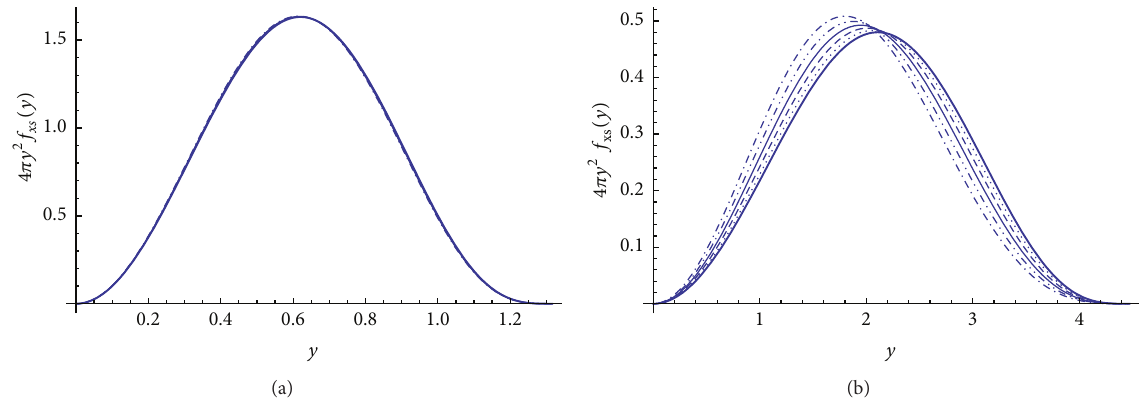
Figure 3: We show the properly normalized velocity distribution obtained in our simple model for negative values of 𝑎 ; that is, 𝑎 = 0, −0.1, −0.2, −0.3,−0.4, −0.5 for the value 𝜉(𝑥𝑠) = √3/2 (a) and a larger, perhaps more realistic, value 𝜉(𝑥𝑠) = 10 (b). The obtained velocity distribution depends mildly on 𝑎 in (a) and it is noticeable in (b). In the plots, 𝑎 is increasing from left to right.